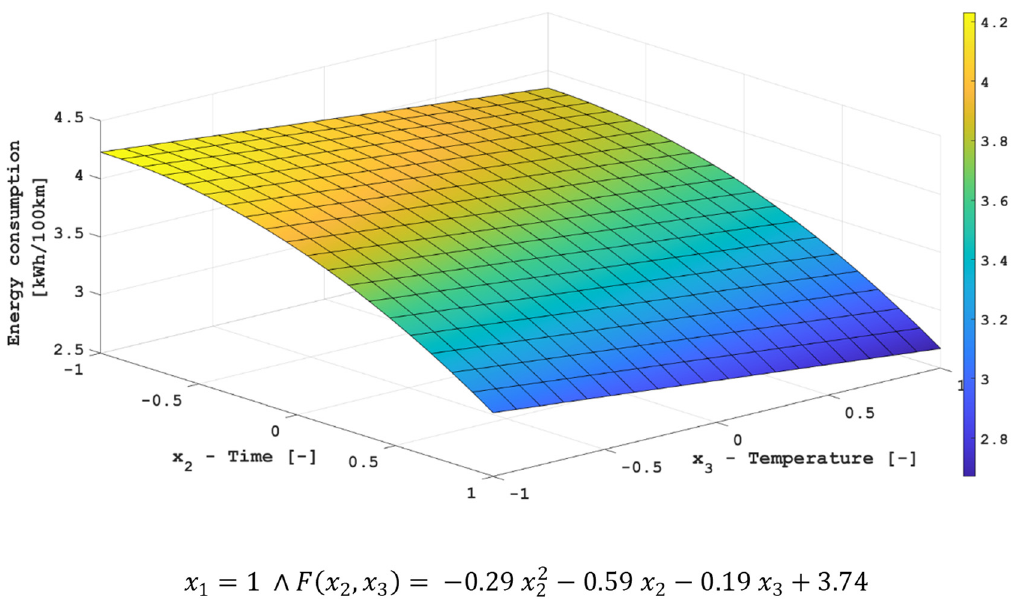
Figure 4. The energy demand of the scooter when covering the route of 15 km.